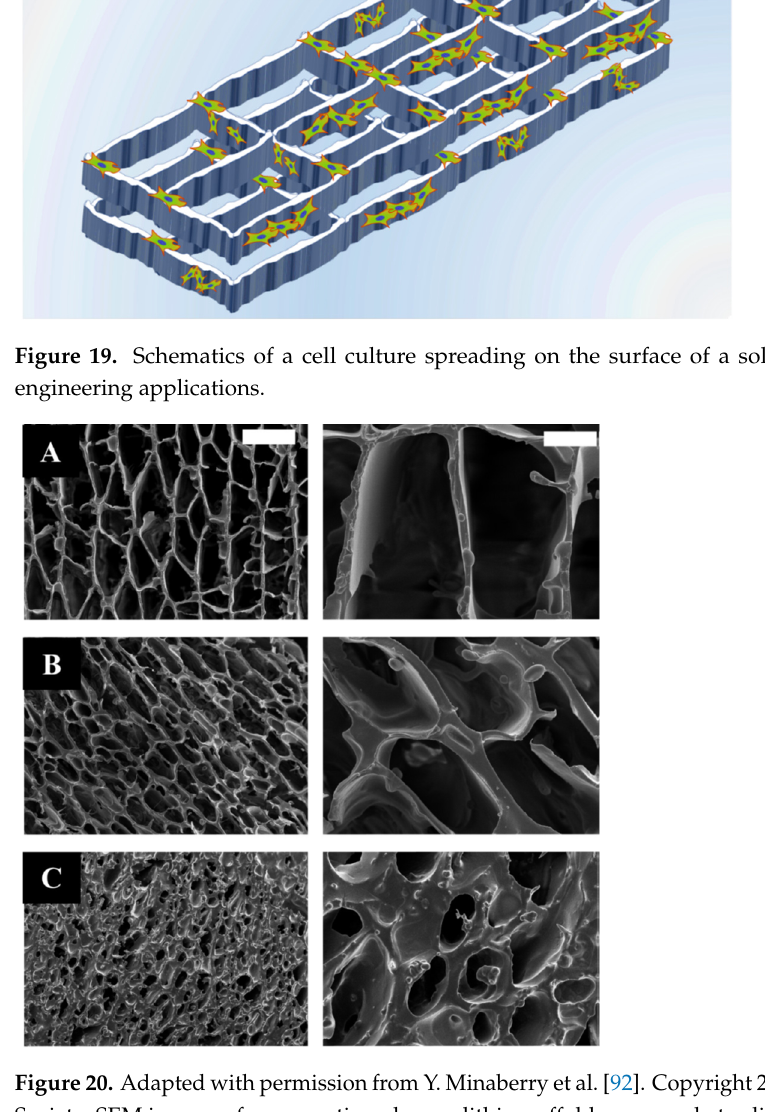
Figure 20. Adapted with permission from Y. Minaberry et al. [92]. Copyright 2011 American Chemical Society. SEM images of cross-sectioned monolithic scaffolds prepared at solid contents and freezing rates of ( A ) 5 wt.%, 1.5·10 − 2 mm s − 1 , ( B ) 7 wt.%, 3·10 − 2 mm s − 1 , and ( C ) 10 wt.%, 6·10 − 2 mm s − 1 . The left scale bar represents 50 μ m, the right bar represents 10 μ m.